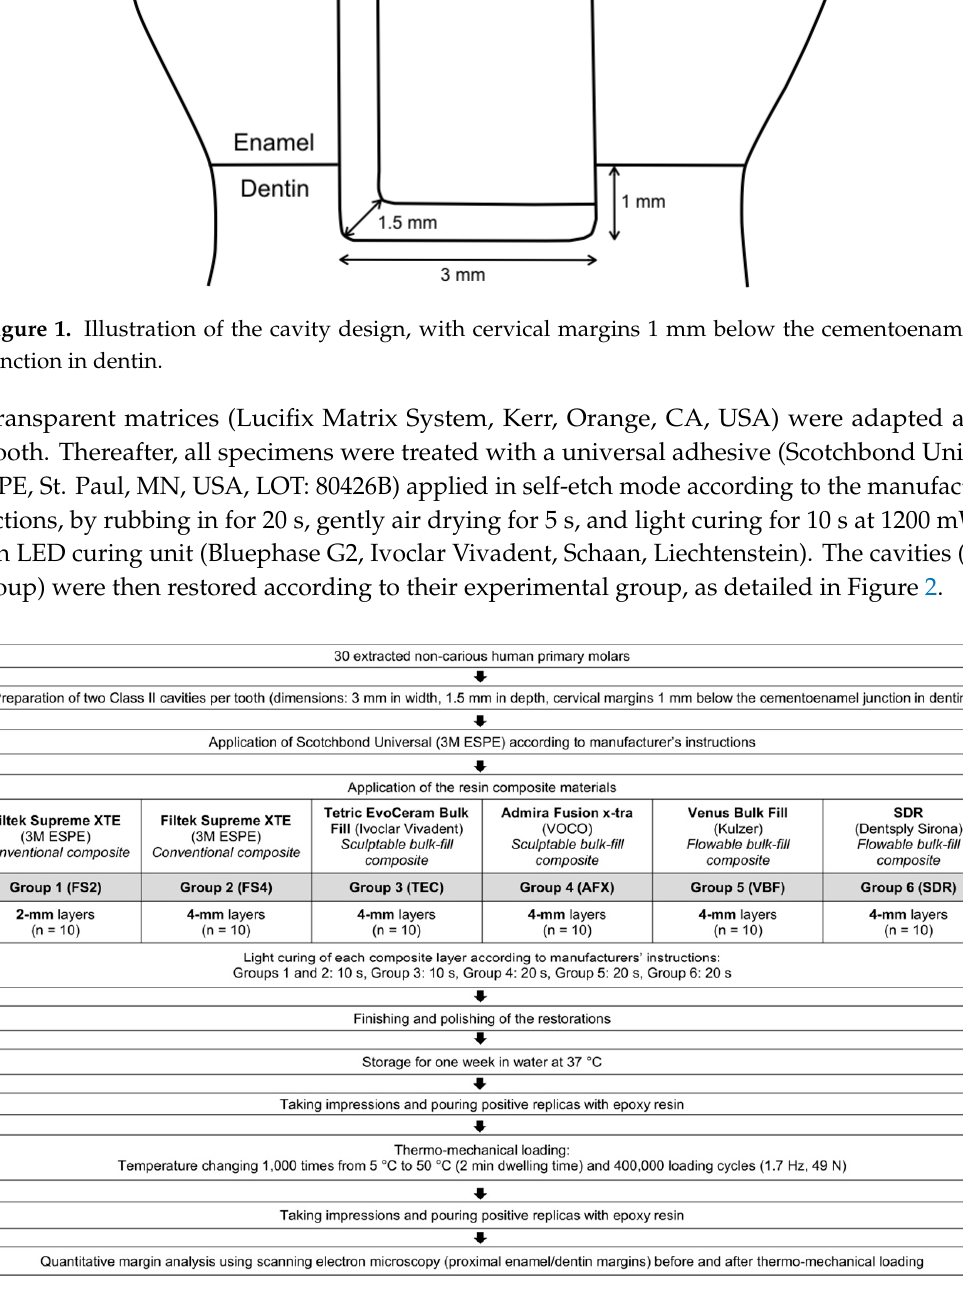
Figure 2. Experimental design. Table 1. Manufacturers’ information on the composite materials used in this study.